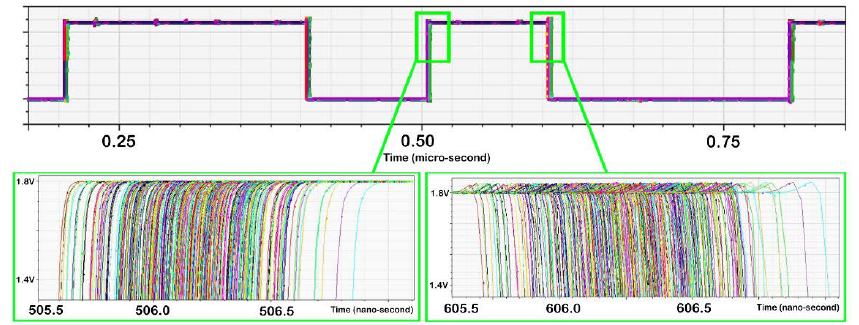
Figure 12. Monte Carlo simulations of demodulated data with 500 iterations.